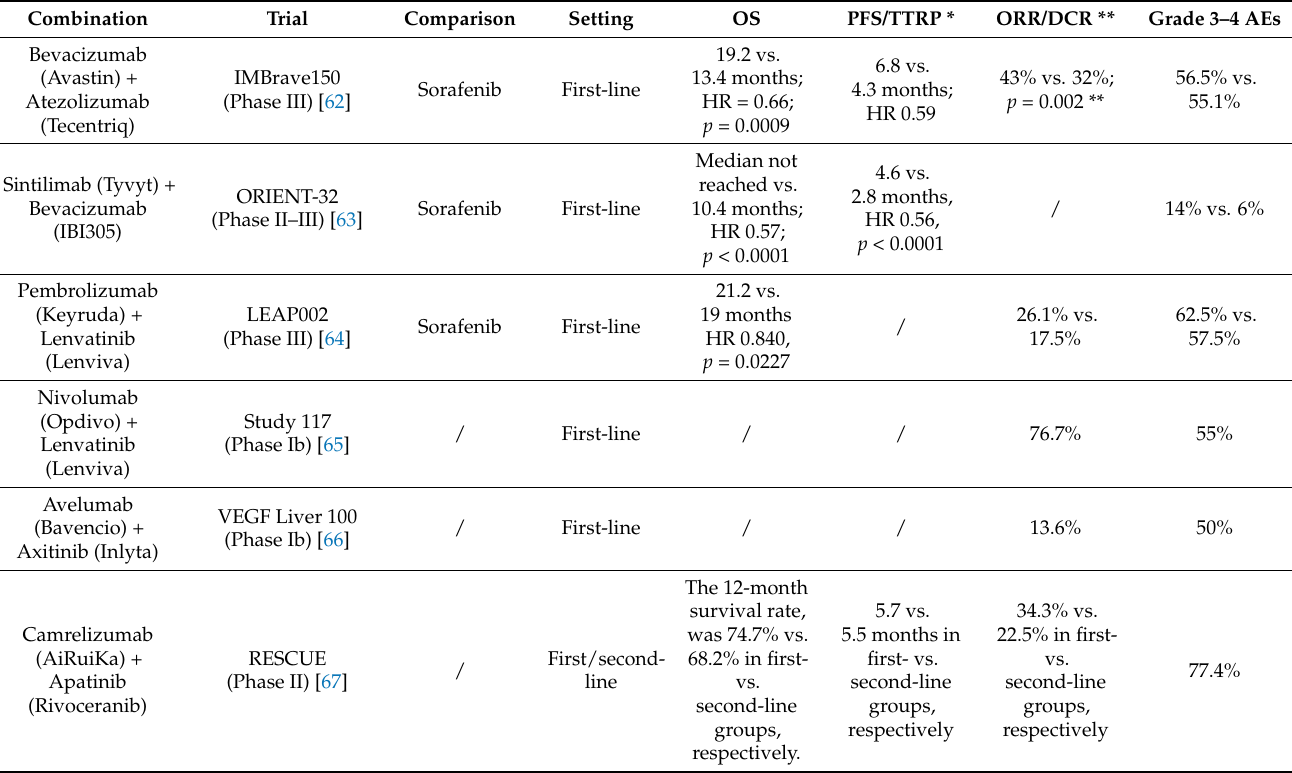
Table 2. PD-L1 inhibitors with angiogenetic drugs for the treatment of advanced